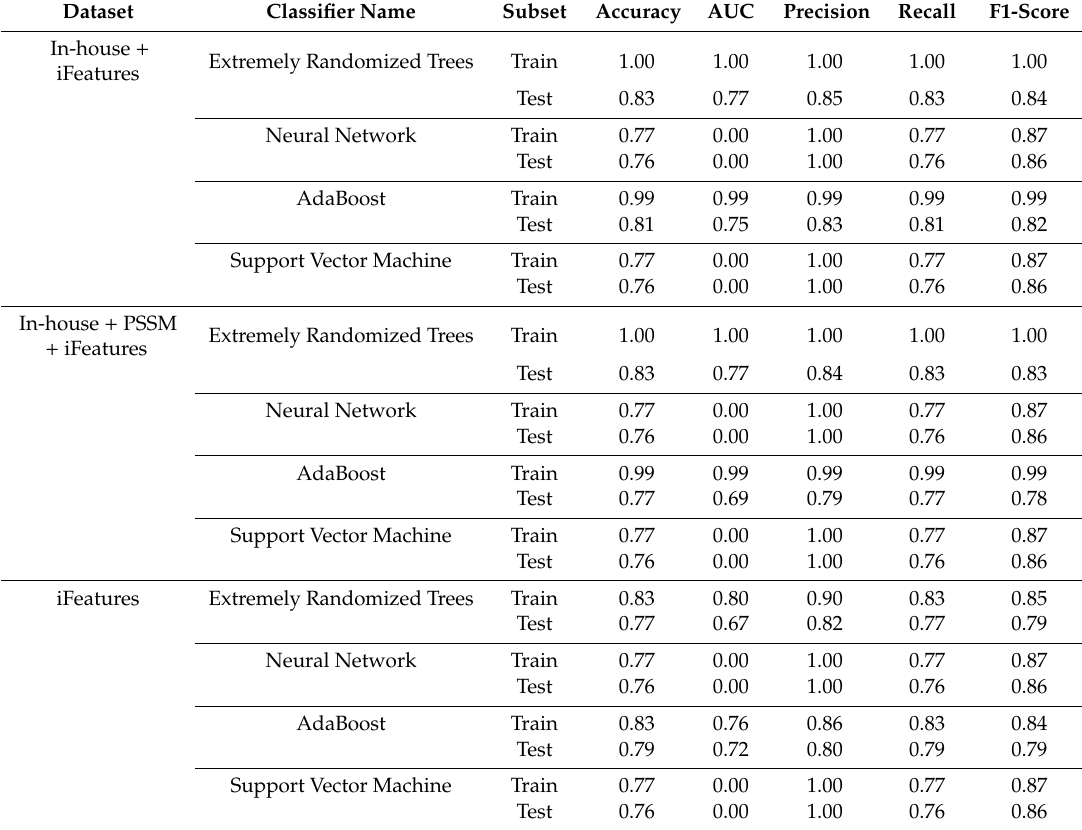
Table A2. Performance metrics for the subsets: The joint dataset with both in-house (one-hot encoding, relative position, literature based and window-based features) and iFeature features (full sequence features); the dataset with in-house, PSSM and iFeature features; and the dataset with only iFeatures.